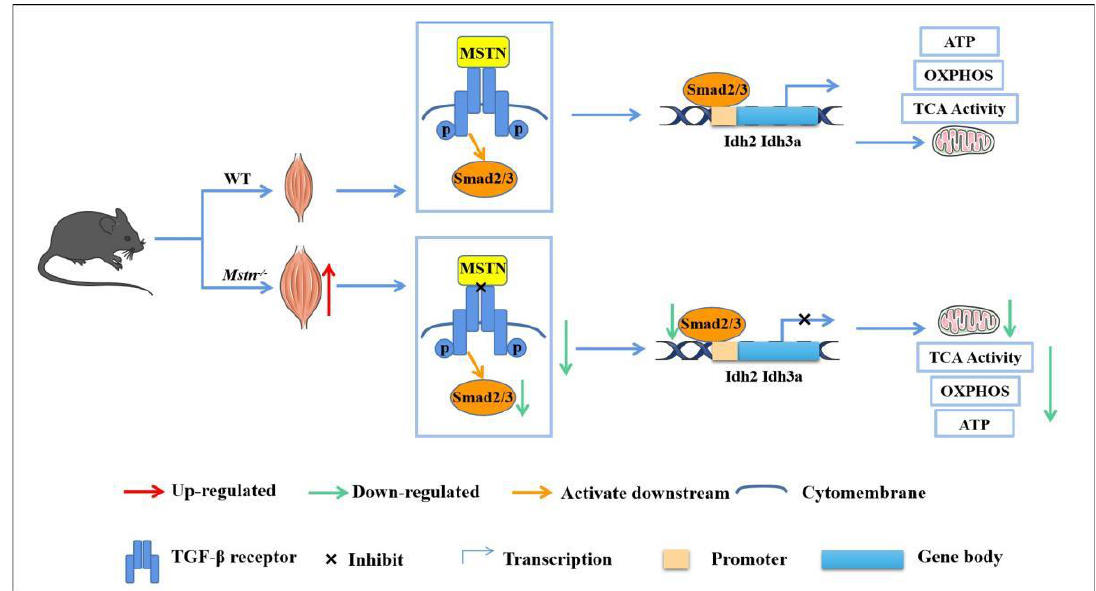
Figure 6. MSTN regulates the expression of IDH through Smad2/3 to affect mitochondrial energy metabolism. Upon MSTN knockdown, binding of MSTN to TGF- β receptors is reduced. This inhibits the entry of Smad2/3 into the nucleus to function as a transcription factor. Less Smad2/3 binds to the promoter regions of Idh2 and Idh3a , and the gene is unable to initiate transcription. The TCA cycle is inhibited, altering mitochondrial morphology and mitochondrial function, and inhibiting ATP production.